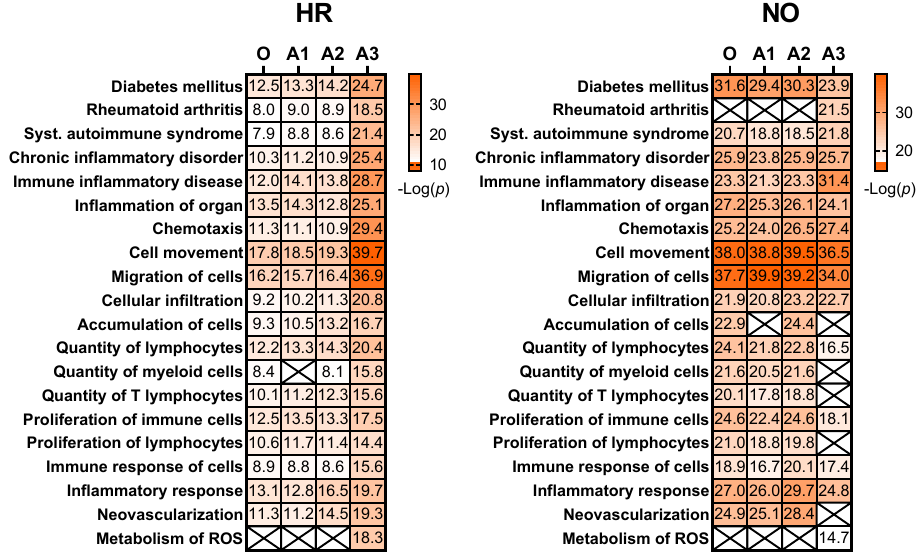
Figure 6. Bar graphs showing the numbers of candidate biomarkers predicted in the amplified datasets only (A1, A2, A3; red), the original data only (blue), or in common in both (purple) for the HR and NO subject groups. Numbers of predicted biomarkers belonging to each group are marked within or above the corresponding bars.